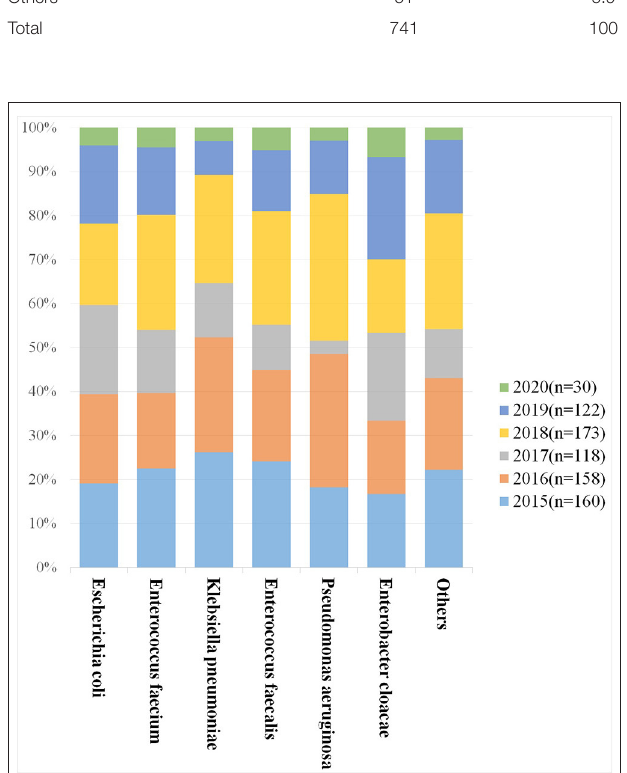
FIGURE 1 | The distribution of bacterium isolated over six years.